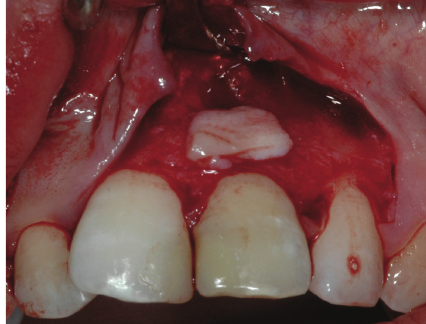
Figure 10: Positioning of the connective graft over the MTA.